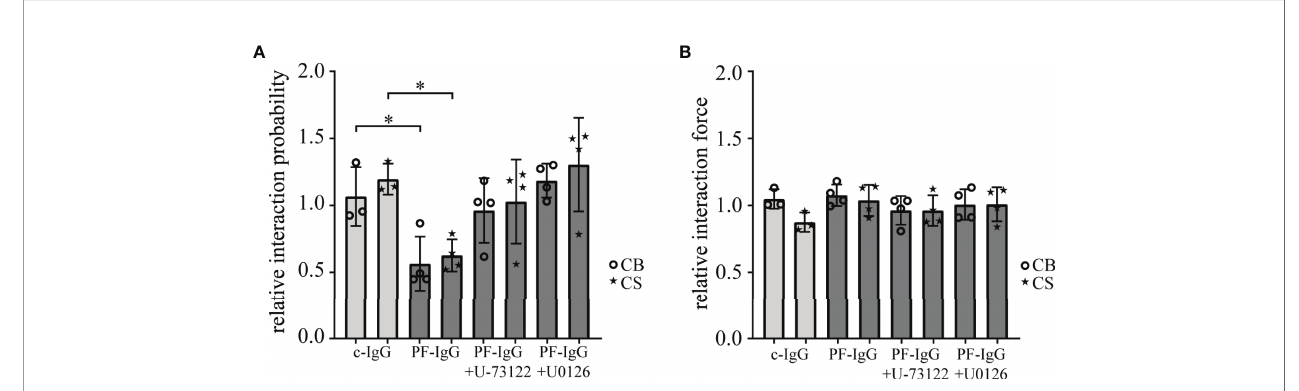
FIGURE 2 | AFM based single-molecule force spectroscopy reveals reduced Dsg1 interaction upon PF-IgG incubation which can be rescued by blocking of ERK1/2 or PLC signaling. Interaction probability (A) and force (B) of desmoglein 1 coated AFM cantilevers after 1 h incubation with IgG and selected mediators compared to pre- incubation values. Measurements were either conducted across the border of two cells (CB) or on the surface above the nucleus of one cell (CS). N ≥ 3; each dot represents the mean value of ≥ 800 force ‒ distance curves from one independent experiment. *P < 0.05 in two-way ANOVA; error bars represent standard